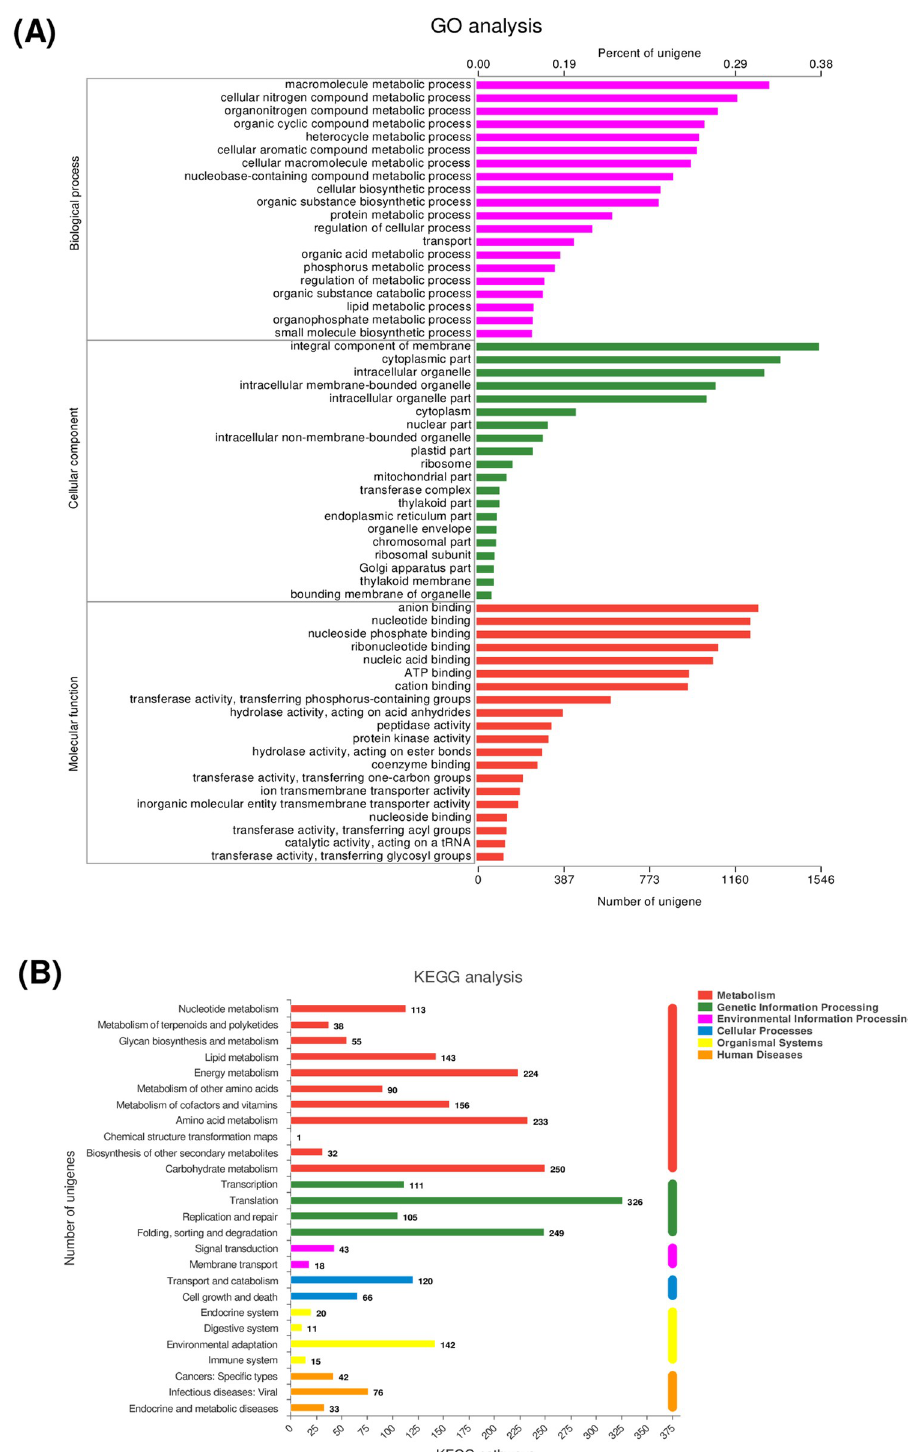
Fig 3. Annotation enrichments and classfications of assembled core unigenes in P . cruentum . ( A ) Histogram of assembled unigene classfications against Gene ontology (GO). The P . cruentum unigenes were systematically classified into three subcategories by GO analysis, including biological process (BP), cellular component (CC), and molecular function (MF). Each bar represents the number of unigenes under each subcategory. ( B ) Pathway enrichment analysis of DEGs by